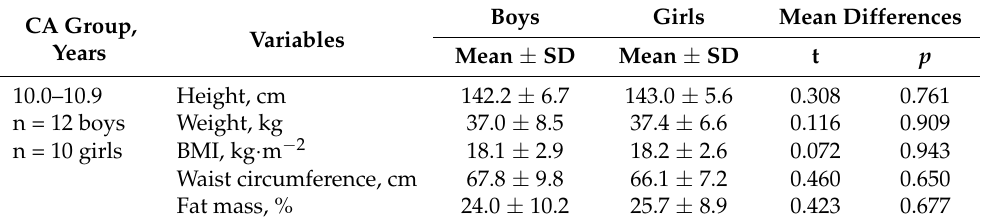
Table 1. Descriptive statistics of body size and comparisons by sex within age groups. CA